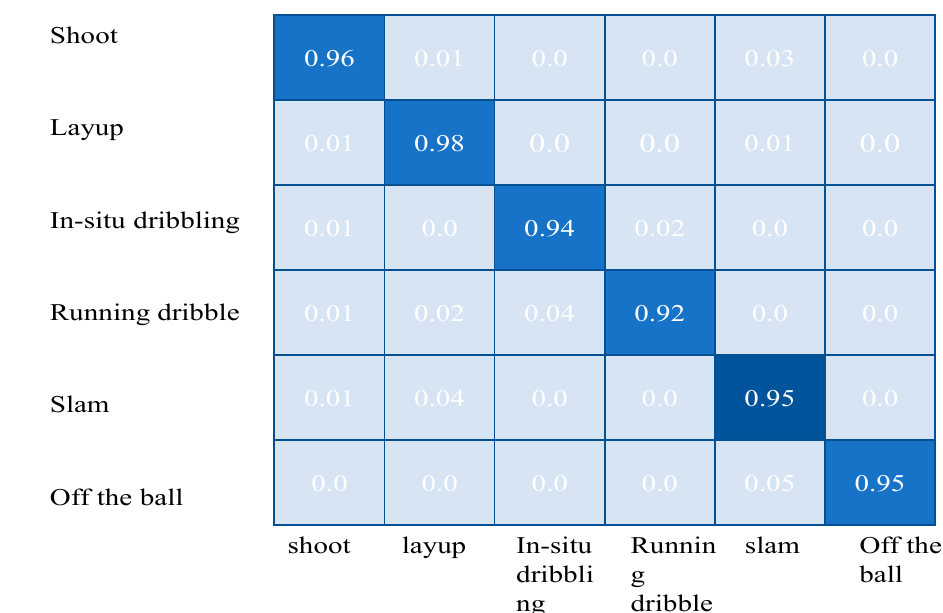
Figure 9. Ball-based action recognition confusion matrix.